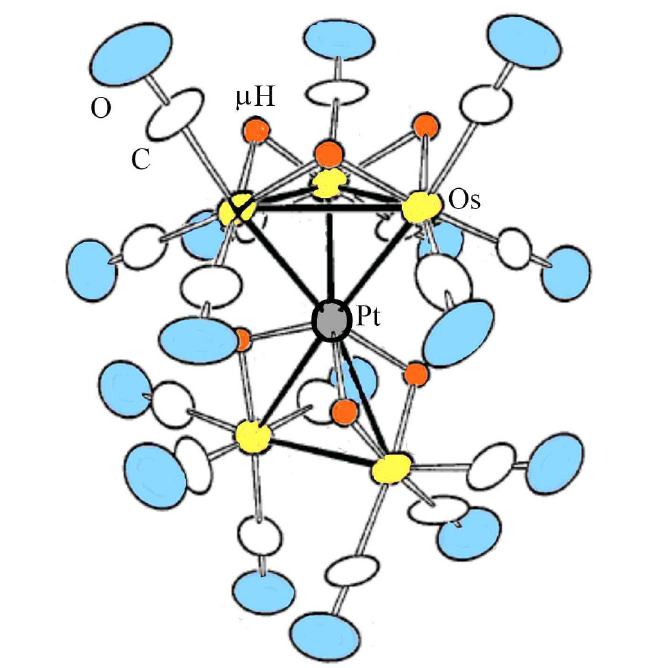
Figure 8. Structure of [PtOs